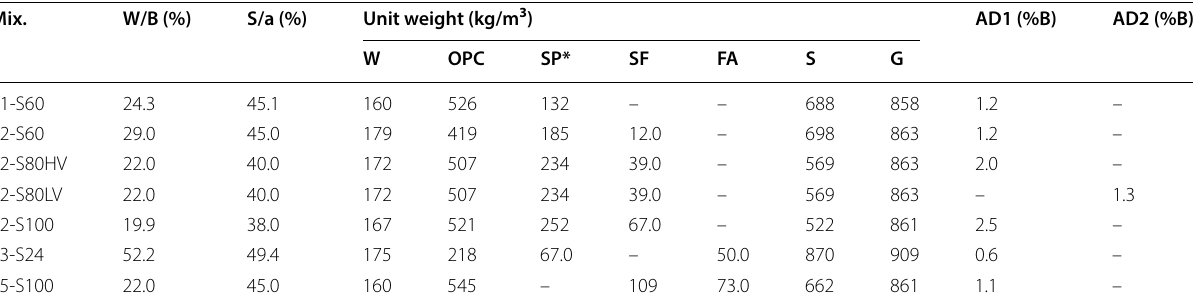
Table 2 Mix proportions of concrete for pumping tests.